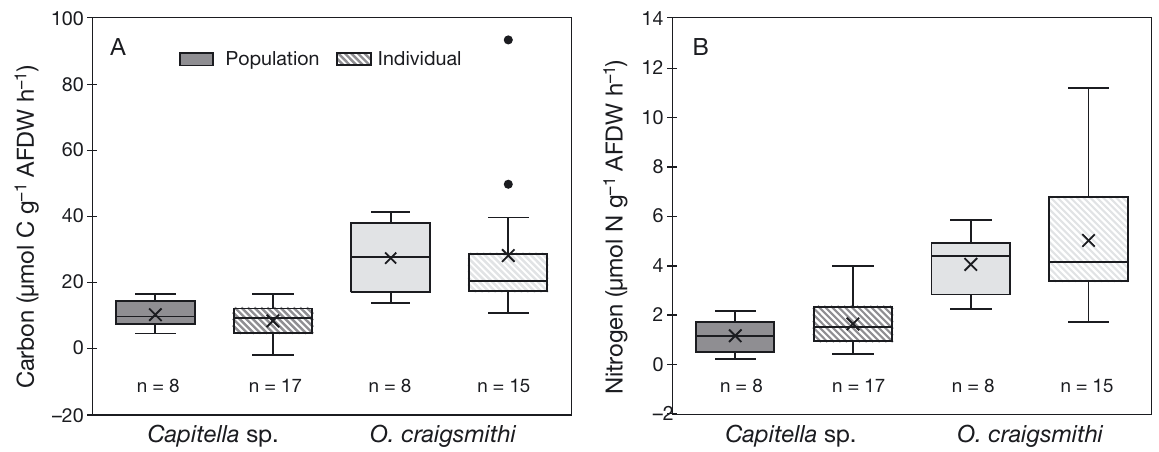
Fig. 1. (A) C and (B) N required for metabolic processes (i.e. respiration and ammonia excretion), measured at population and individual scale for Capitella sp. and Ophryotrocha craigsmithi fed fresh salmon faeces. C requirement based on respiration measurements; nitrogen requirement based on ammonia excretion measurements. Box: interval between lower and upper quartiles of the distributions; cross: mean value; whiskers: minimum and maximum. Data of O. craigsmithi log transformed before statistical analyses. Within each species, no significant differences (p > 0.05) were found between measurements at population or individual scale for both C and N